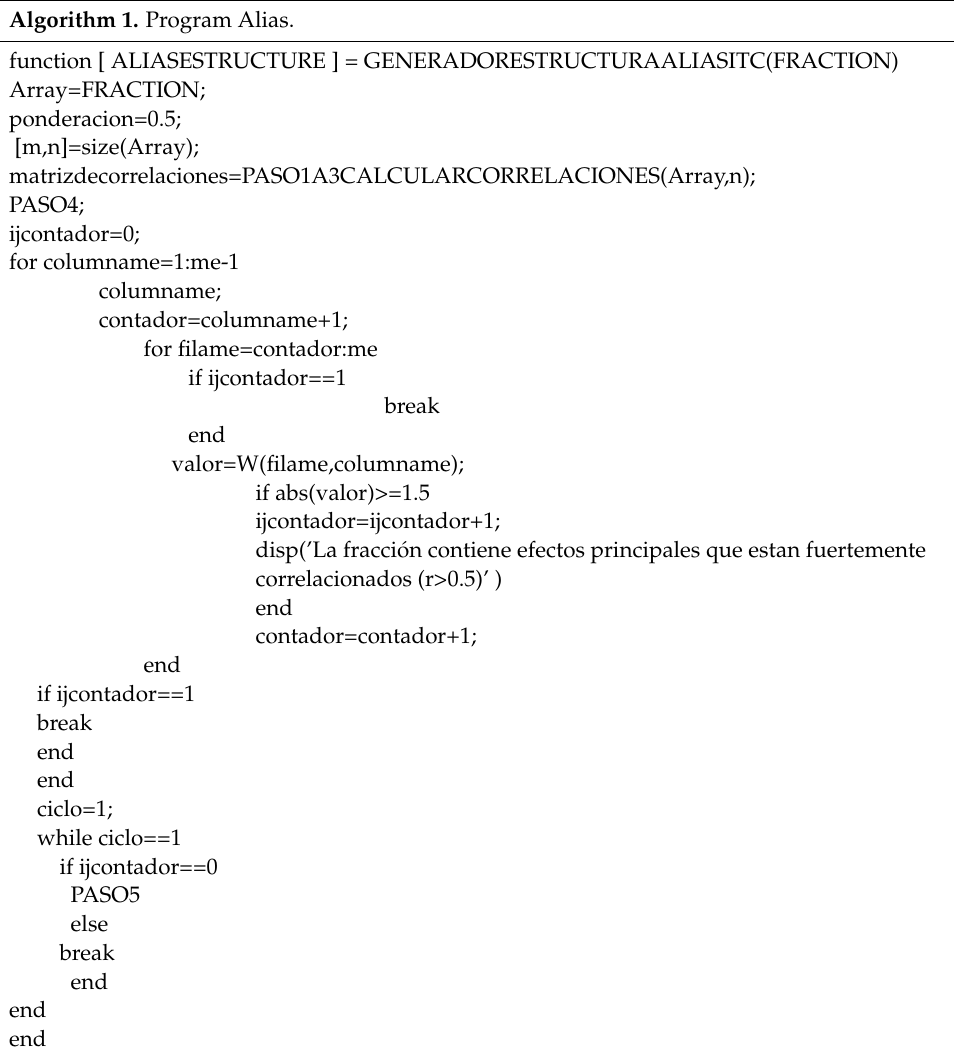
Algorithm 1. Program